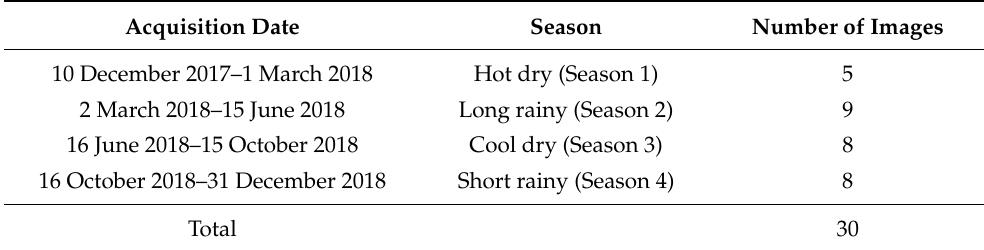
Table 5. Sentinel-1 backscatter data acquisition dates and their specific seasons in the years 2017 and